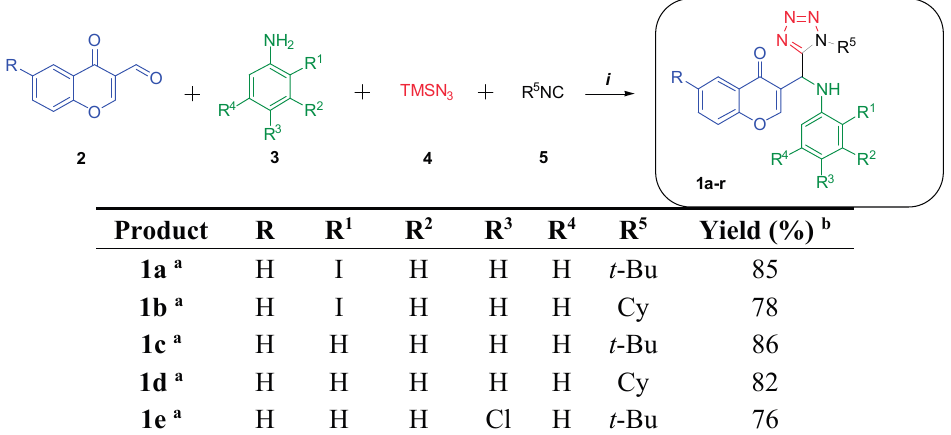
Table 1. Synthesis of the chromone-tetrazoles 1a – n a and the fluorine-containing chromone-tetrazoles 1o – r